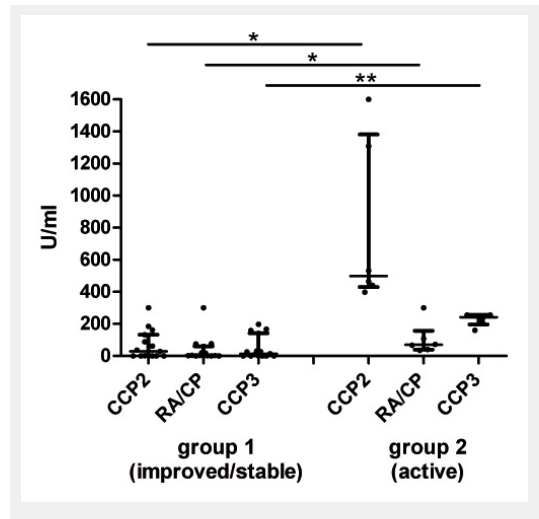
Lower ACPA levels in RA patients with inactive or ameliorated disease during pregnancy. ACPA levels measured by three different ACPA ELISA (CCP2 ELISA, RA/CP ELISA and CCP3 ELISA) at the third trimester in RA patients with low disease activity during pregnancy (group 1, n = 16) and in those with persistent active disease during pregnancy (group 2, n = 6). Lines show median and interquartile range; * P <0.05, ** P